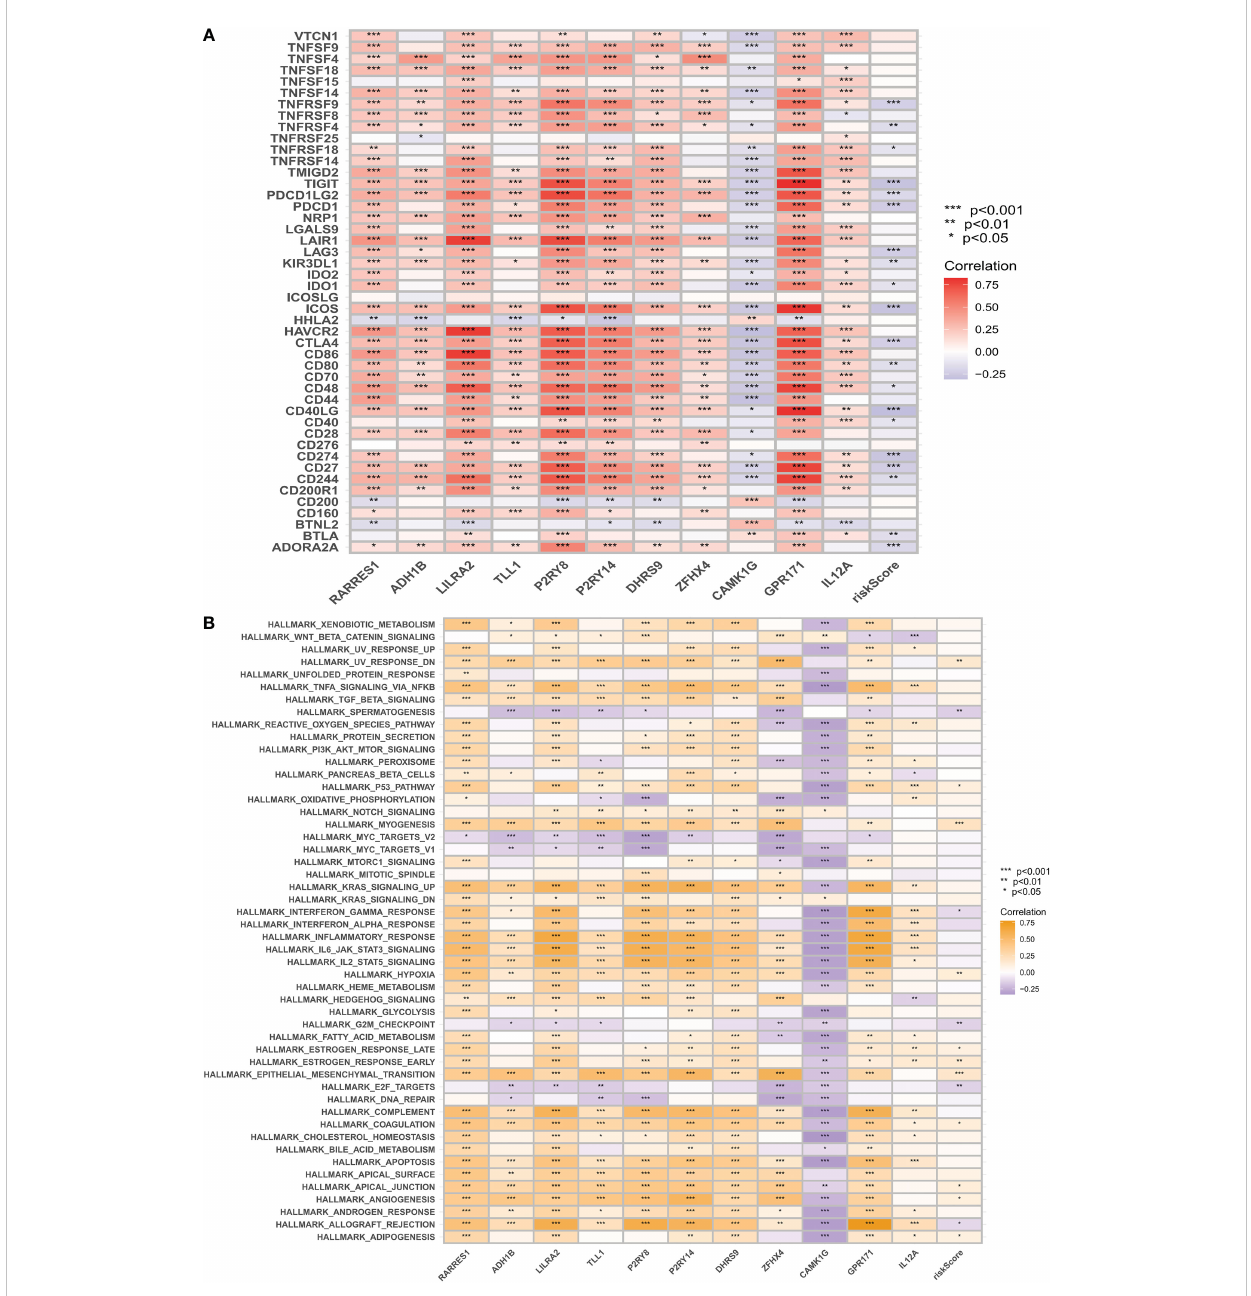
FIGURE 9 Immune checkpoint correlation analysis and GSVA correlation analysis. (A) Correlation of expression of all immune checkpoints with risk score-related genes and risk scores. (B) GSVA was used to analyze the correlation between the MiSigDB Hallmark pathway and risk scores. *p < 0.05, **p < 0.01, ***p <